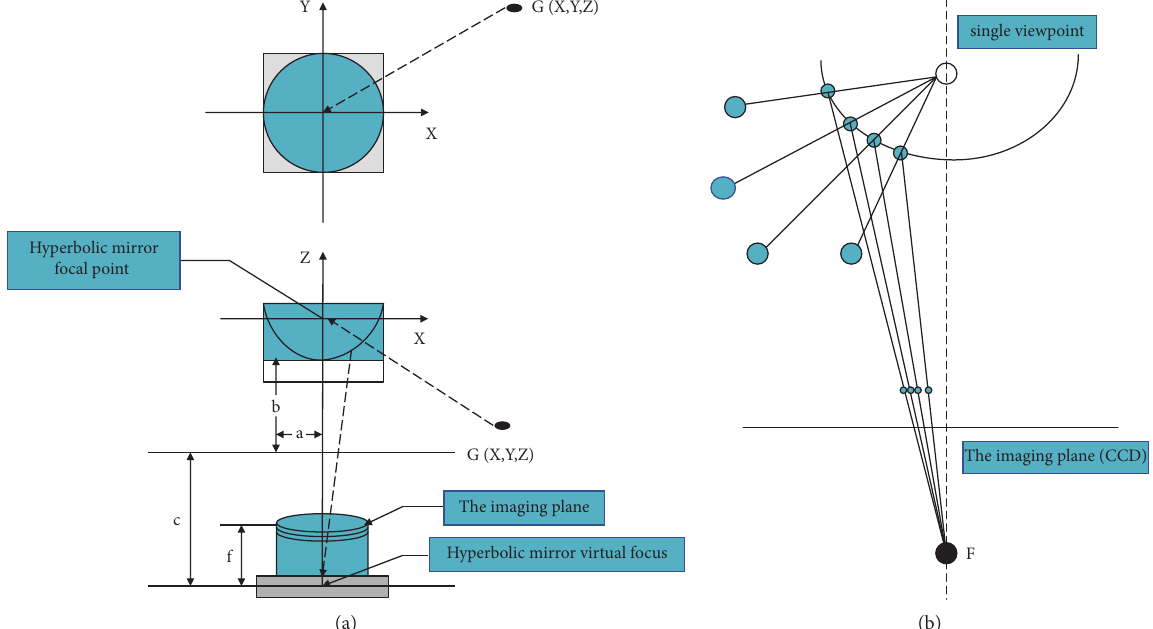
Figure 3: Schematic diagram of omnidirectional vision sensor with a single viewpoint. (a) ODVS structure; (b) single view constraint properties in ODVS.